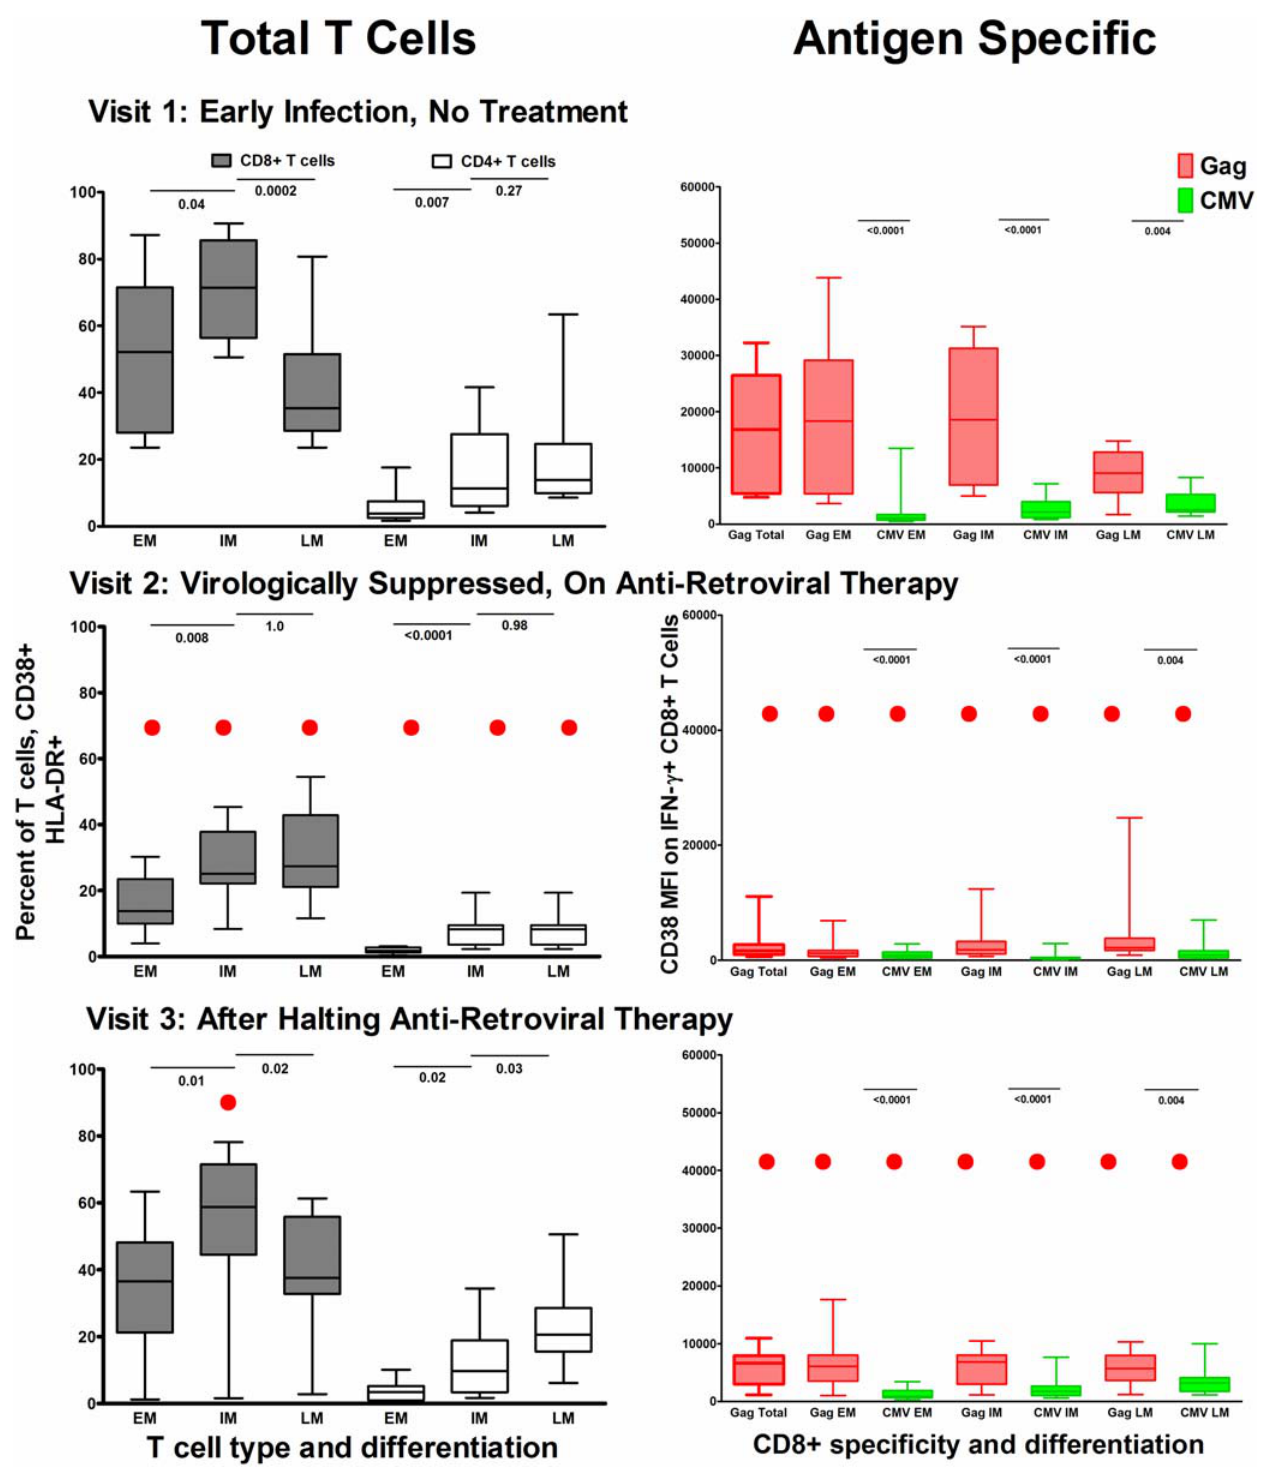
Figure 4. Activation levels on total and antigen specific T cells by differentiation stage. In the first column the proportion of total T cells (CD8 + and CD4 + ) expressing CD38 and HLA-DR activation markers by T cell maturation category are displayed and defined as early memory (CD27 + CD28 + ) EM, intermediate memory (CD27 + CD28 2 ) IM, and late memory (CD27 2 CD28 2 ) LM. In columns 2 the CD38 MFI level is shown by maturation stage for CD8 + T cell IFN- c responses to both HIV-1 Gag (red) and CMV pp65 (green). And in column 3 the CD38 MFI is shown for each maturation stage of CD4 + T cell IFN- c responses to HIV-1 Gag (red) and CMV pp65 (green). Row 1 displays measurements for visit 1, prior to antiretroviral therapy. Row 2 displays measurements for visit 2, during a virologically suppressive anti-retroviral regimen, and row 3 displays measurements for visit 3, after patients had halted an anti-retroviral regimen and viremia had rebounded. Black bars indicate differences between activation levels by response categories (Wilcoxon 2 Sample Test). Red dots notes a significant change from baseline (visit 1) values (Sign Rank Test).